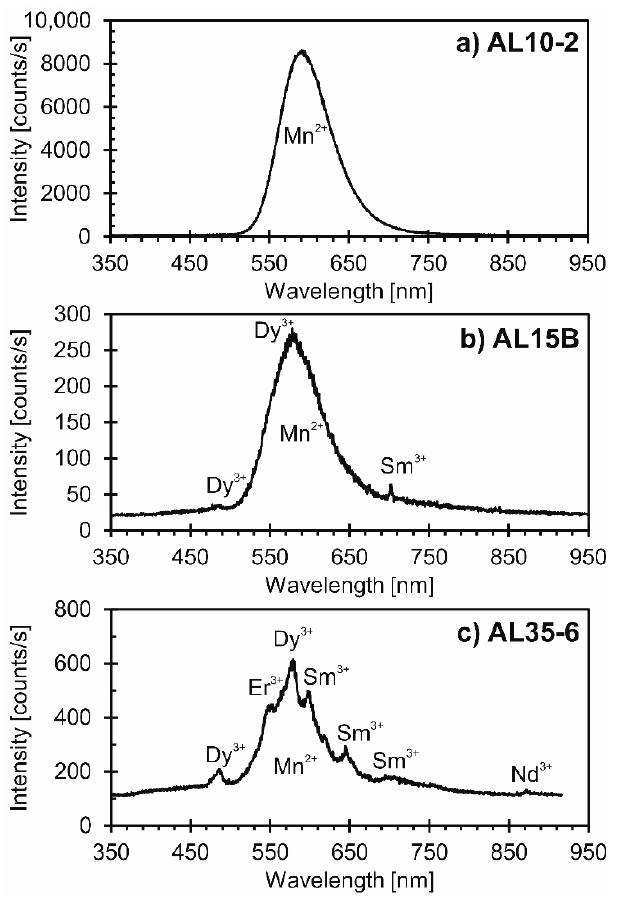
Figure 7. ( a – c ) Representative cathodoluminescence spectra collected from apatite crystals in three BIF samples. CL spectra for all the studied specimens are included in the Supplementary Materials (Figure S2). Mn 2 + is the dominant luminescence activator in Isua apatite. A very intense, broad peak in the yellow-green part of the spectra corresponding to Mn 2 + may overlap with other types of luminescence centers, which appear in the spectrum of AL35-6 ( c ).